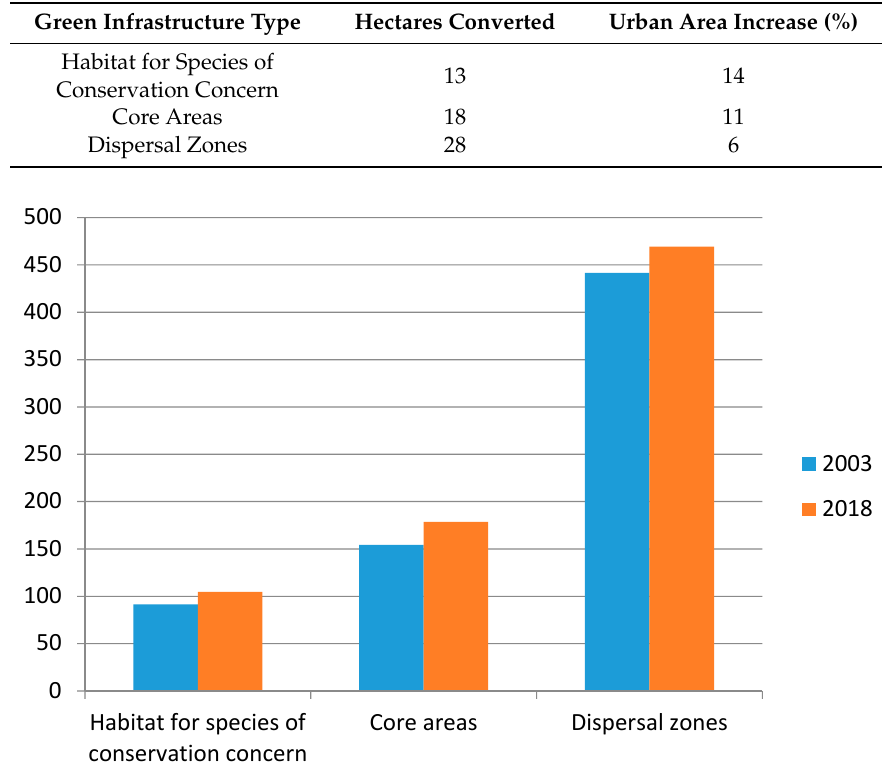
Figure 6. Change in urban hectares between 2003 and 2018 within the three ecologically significant categories of the green infrastructure of Stockholm City.